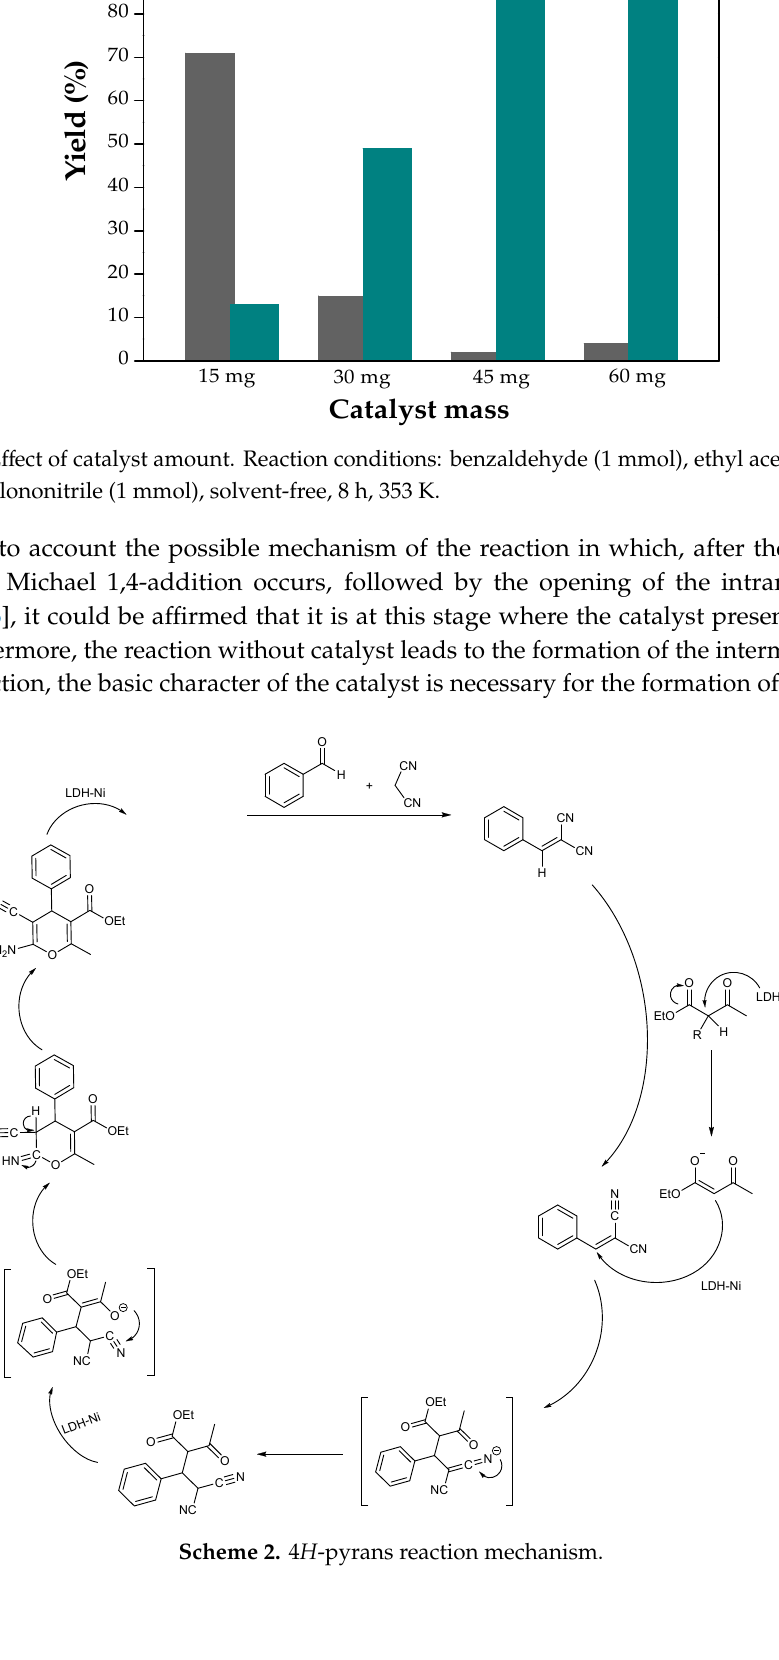
Scheme 2. 4 H -pyrans reaction mechanism.